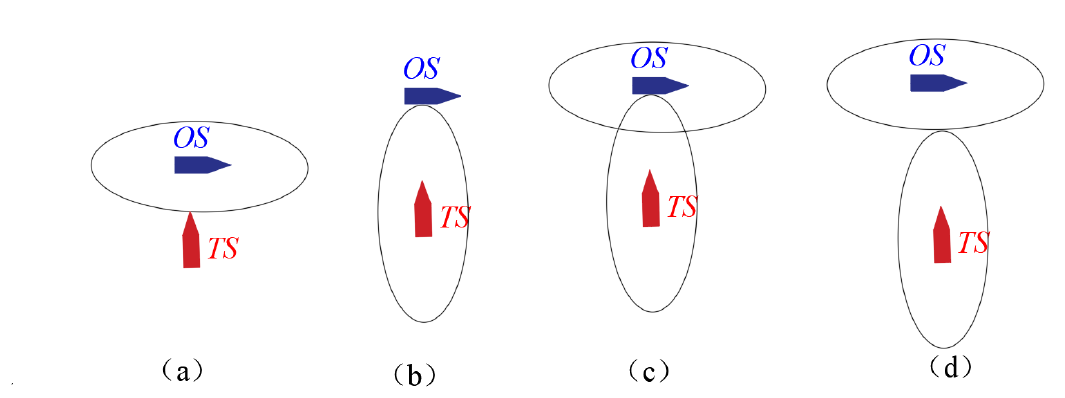
Figure 1. Different domain-based safety criteria [13]: ( a ) OS domain is not violated; ( b ) target ship (TS) domain is not violated; ( c ) neither of the ship domains should be violated; ( d ) ship domains should not